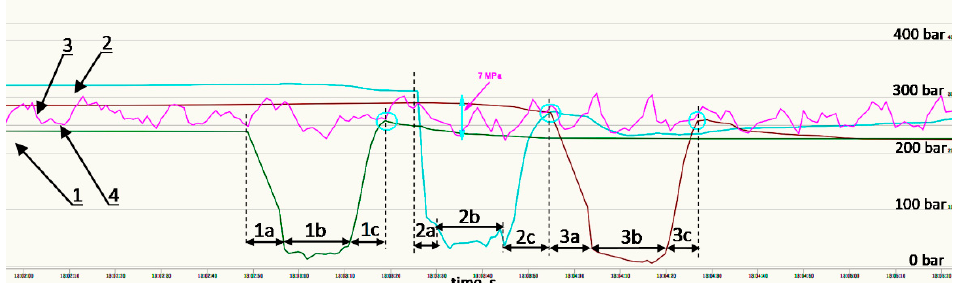
Figure 6. The course of the registered pressure drop and working time for the support legs: 1, powered support no. 45; 1a, leg withdrawal time 8 s; 1b, adjustment time 14.5 s; 1c, expansion time